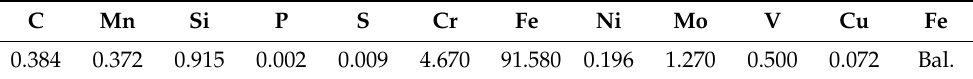
Table 1. Chemical composition of the base material X38CrMoV5-1 (wt.%).